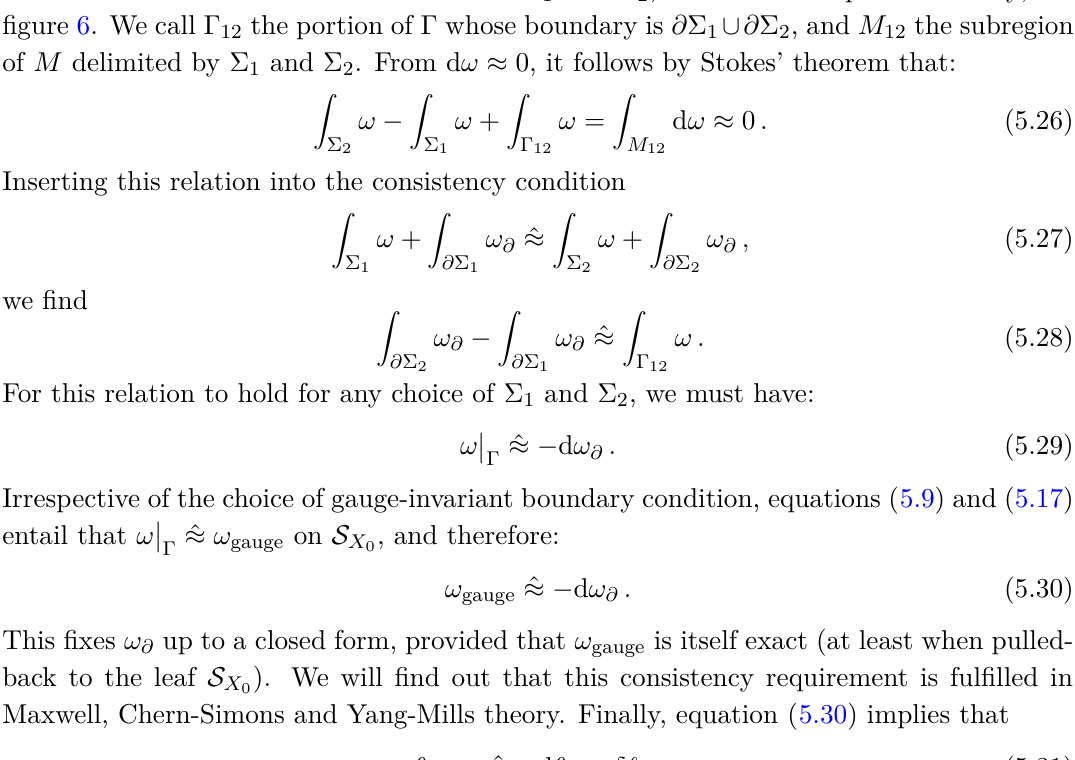
and ∂ Σ , while M designates the portion of M delimited by Σ and Σ . 1 2 12 1 2 . We call ω (resp. θ ) the M ∂ ∂